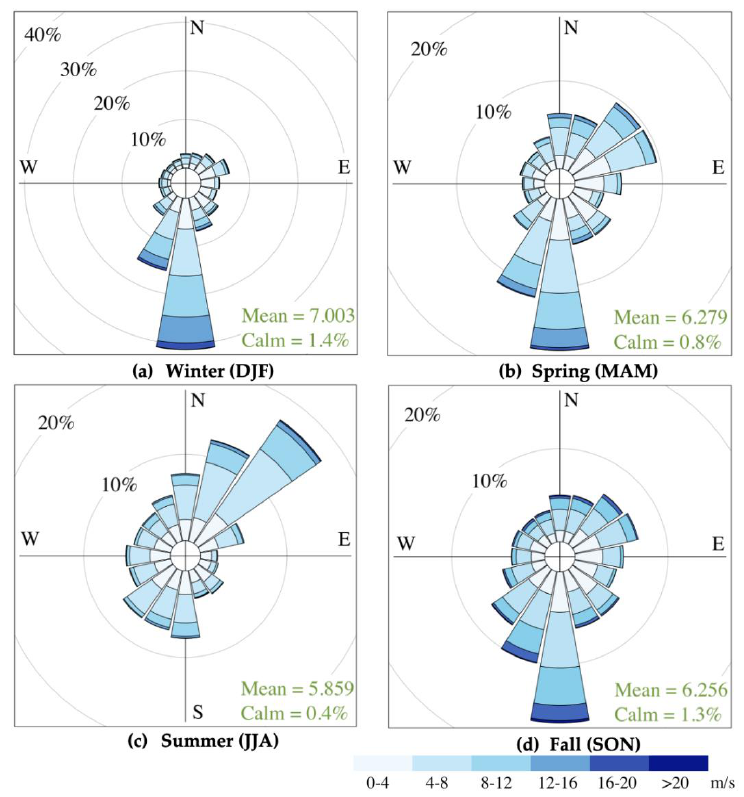
Figure 4. Mean wind distribution throughout the year recorded at the weather station “The Island of Dikson” (WMO ID: 20674) for 15 years of observations (2005–2020): frequency of counts (%) and speed (m/s).